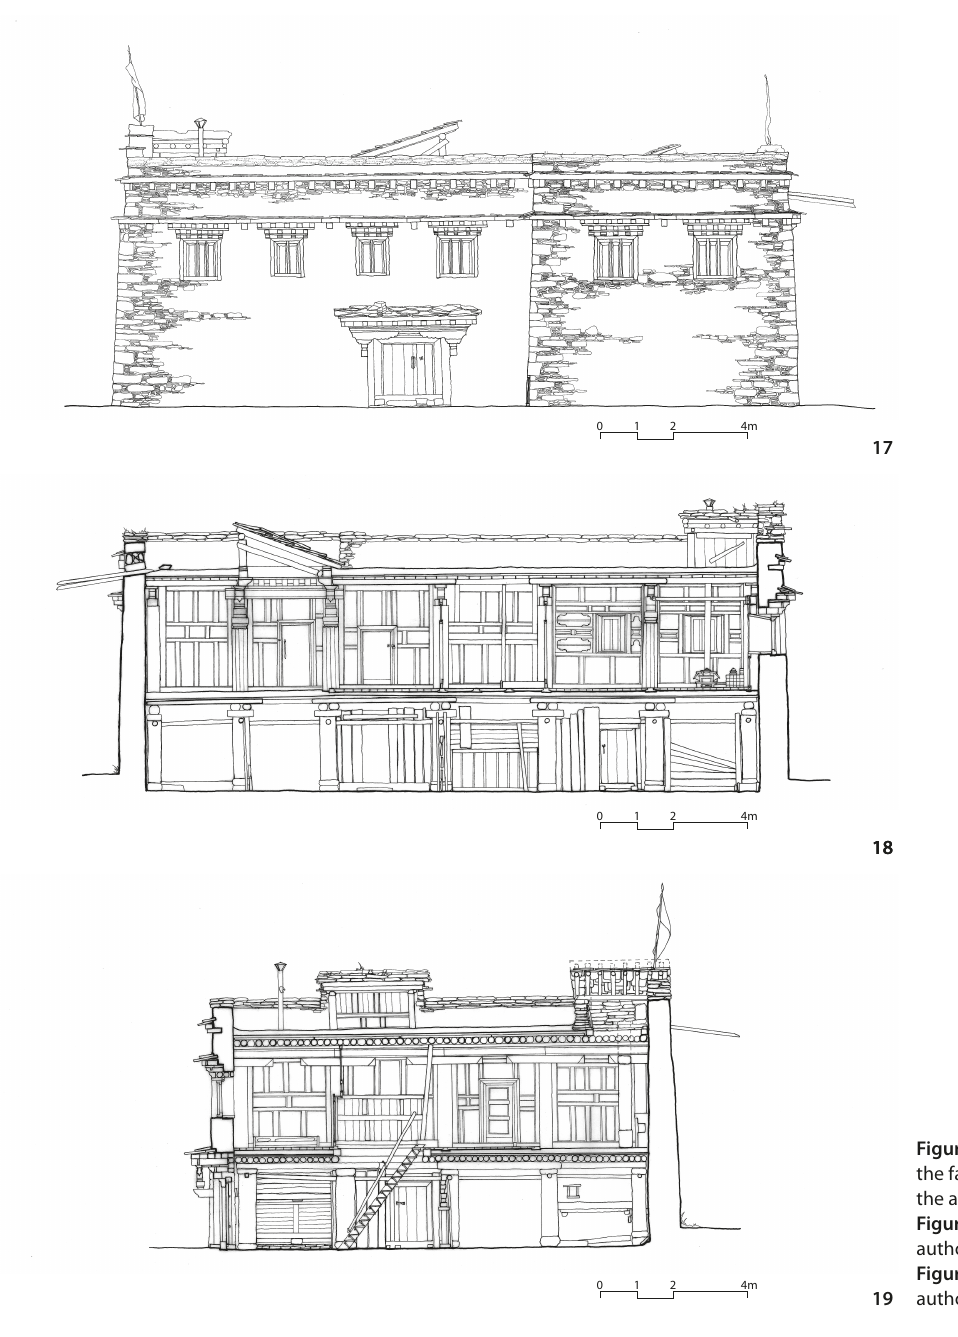
Figure 17 Southeast elevation of the farmhouse in Dabpa